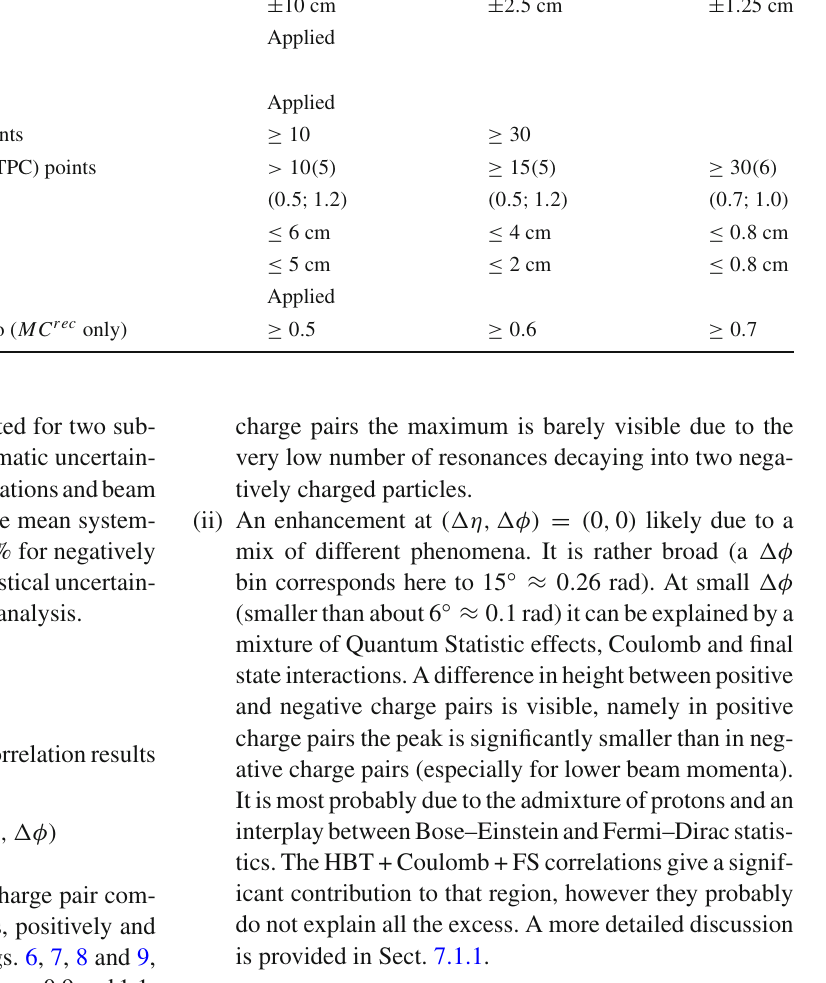
Event cuts Interactions Applied Good vertex Applied Vertex z pos. ± 10 cm Centrality